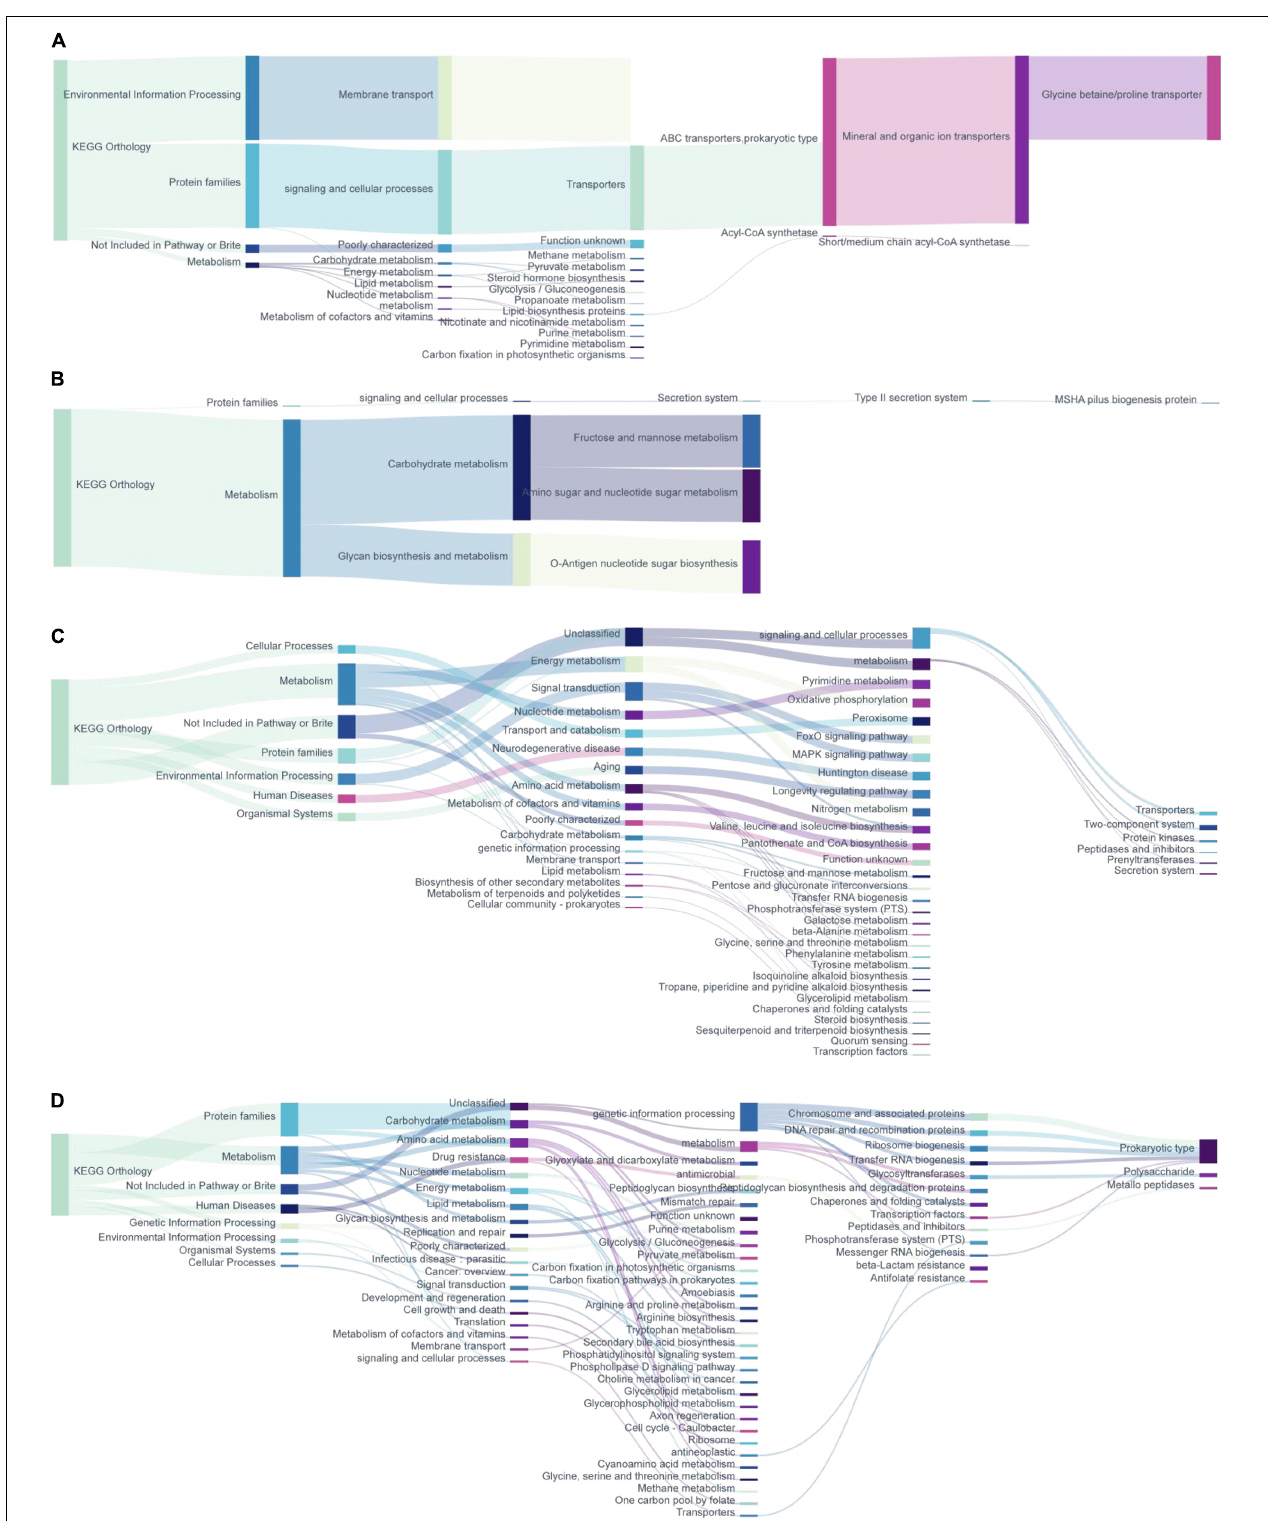
FIGURE 5 | The metagenomic function prediction of the KEGG Orthology. (A) KEGG Orthology of the KOs with significantly increased expression in intestinal contents of repeated stress-related diarrhea mice. (B) KEGG pathway of the KOs with significantly decreased expression in intestinal contents of repeated stress-related diarrhea mice. (C) KEGG Orthology of the KOs with significantly increased expression in intestinal mucosa of repeated stress-related diarrhea mice. (D) KEGG Orthology of the KOs with significantly decreased expression in intestinal mucosa of repeated stress-related diarrhea mice.